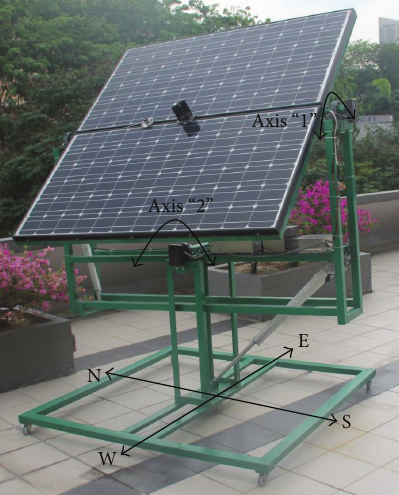
Figure 4: The hardware prototype of the DAST and its rotational